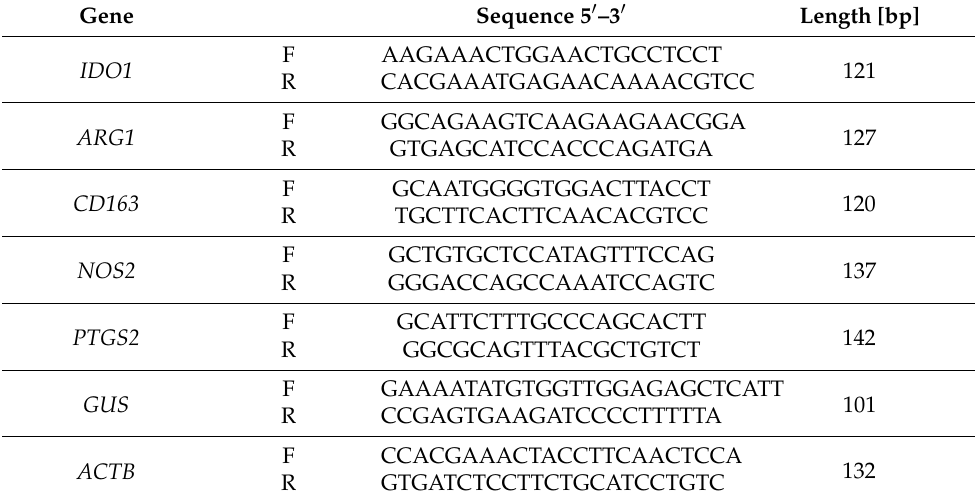
Table 1. Sequences of primers with expected product